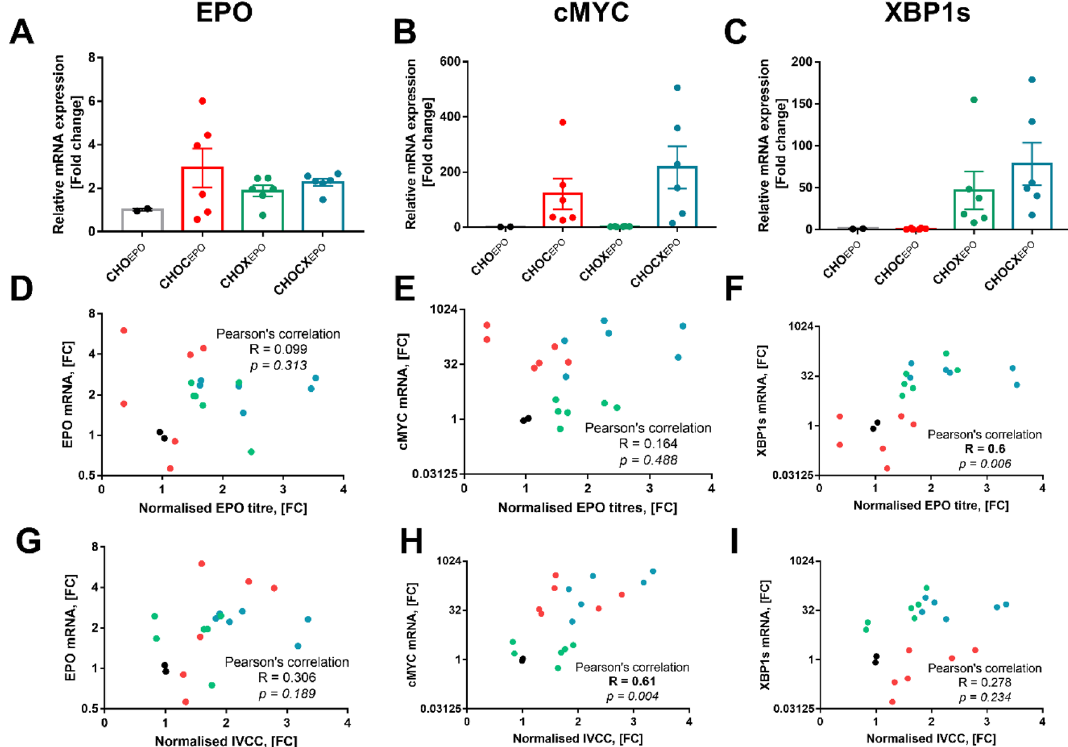
Figure 3. Relative mRNA expression of recombinant EPO, MYC and XBP1 and their relationship with recombinant EPO production. ( black ) CHOEPO cell line; ( red ) CHOC EPO cell line; ( green ) CHOX EPO cell line; ( blue ) CHOCX EPO cell line. ( A , B ) and C) mRNA expression of EPO, MYC and XBP1, respectively, normalised using GAPDH as internal standard. Samples for mRNA expression analysis correspond to day 3. ( D – F ) Comparison between normalised EPO titres ( x -axis) and mRNA levels of EPO, MYC and XBP1s ( y -axis), respectively. ( G – I ) Comparison between normalised IVCC titres ( x -axis) and mRNA levels of EPO, MYC and XBP1s ( y -axis), respectively. Each dot corresponds to a replicate derived from CHOEPO cells as well as from three independent single-cell derived CHOC EPO , CHOX EPO and CHOCX EPO cell